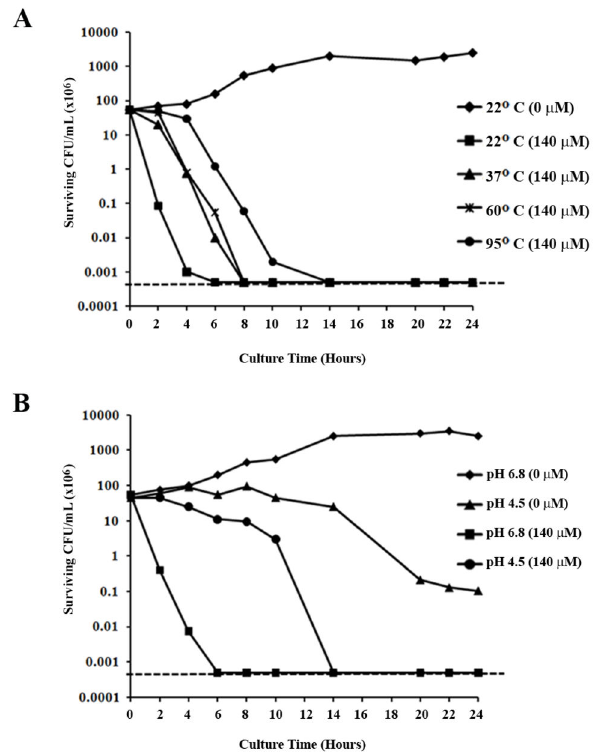
and bactericidal activity of